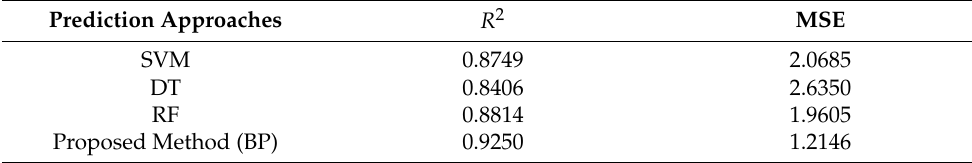
Table 5. Evaluation Result of Predictive Capacity.